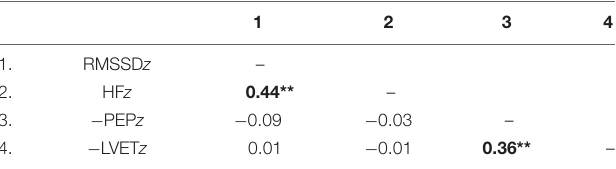
TABLE 2 | Zero-order correlations among variables used to calculate cardiac autonomic balance and cardiac autonomic